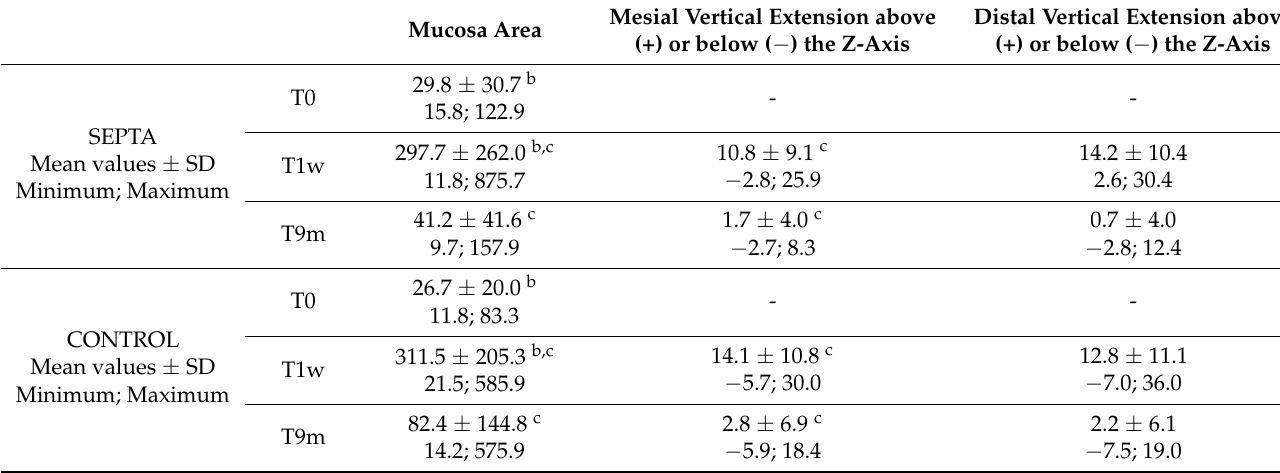
Table 3. Radiographic anatomical measures in the lateral view of CBCTs taken at T0 (before surgery), at T1w (1 week after surgery), and at T9m (9 months after surgery). Data in millimeters or square millimeters only for the virtual mucosa area. Mesial Vertical Extension above Distal Vertical Extension above (+) or below ( − ) the Z-Axis (+) or below ( − ) the